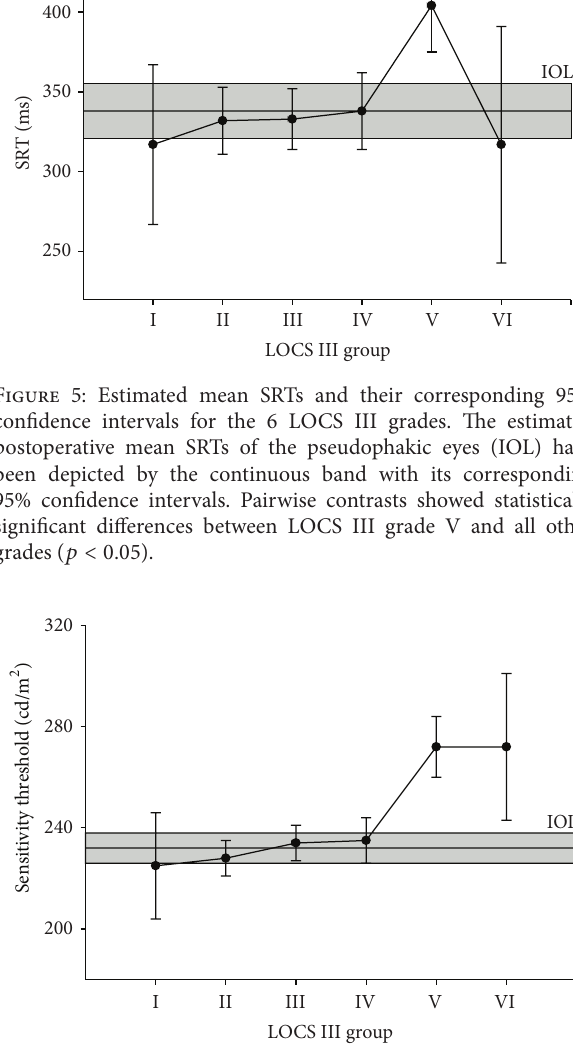
Figure 6: Estimated mean sensitivity (cd/m 2 ) and their corre- sponding 95% confidence intervals for the 6 LOCS III grades. The estimated postoperative mean sensitivity of the pseudophakic eyes has been depicted by the continuous band with its corresponding 95% confidence intervals. Pairwise contrasts showed statistically significant differences between LOCS III grades V ( 𝑝 < 0.001 ) and VI ( 𝑝 < 0.05 ) and all other